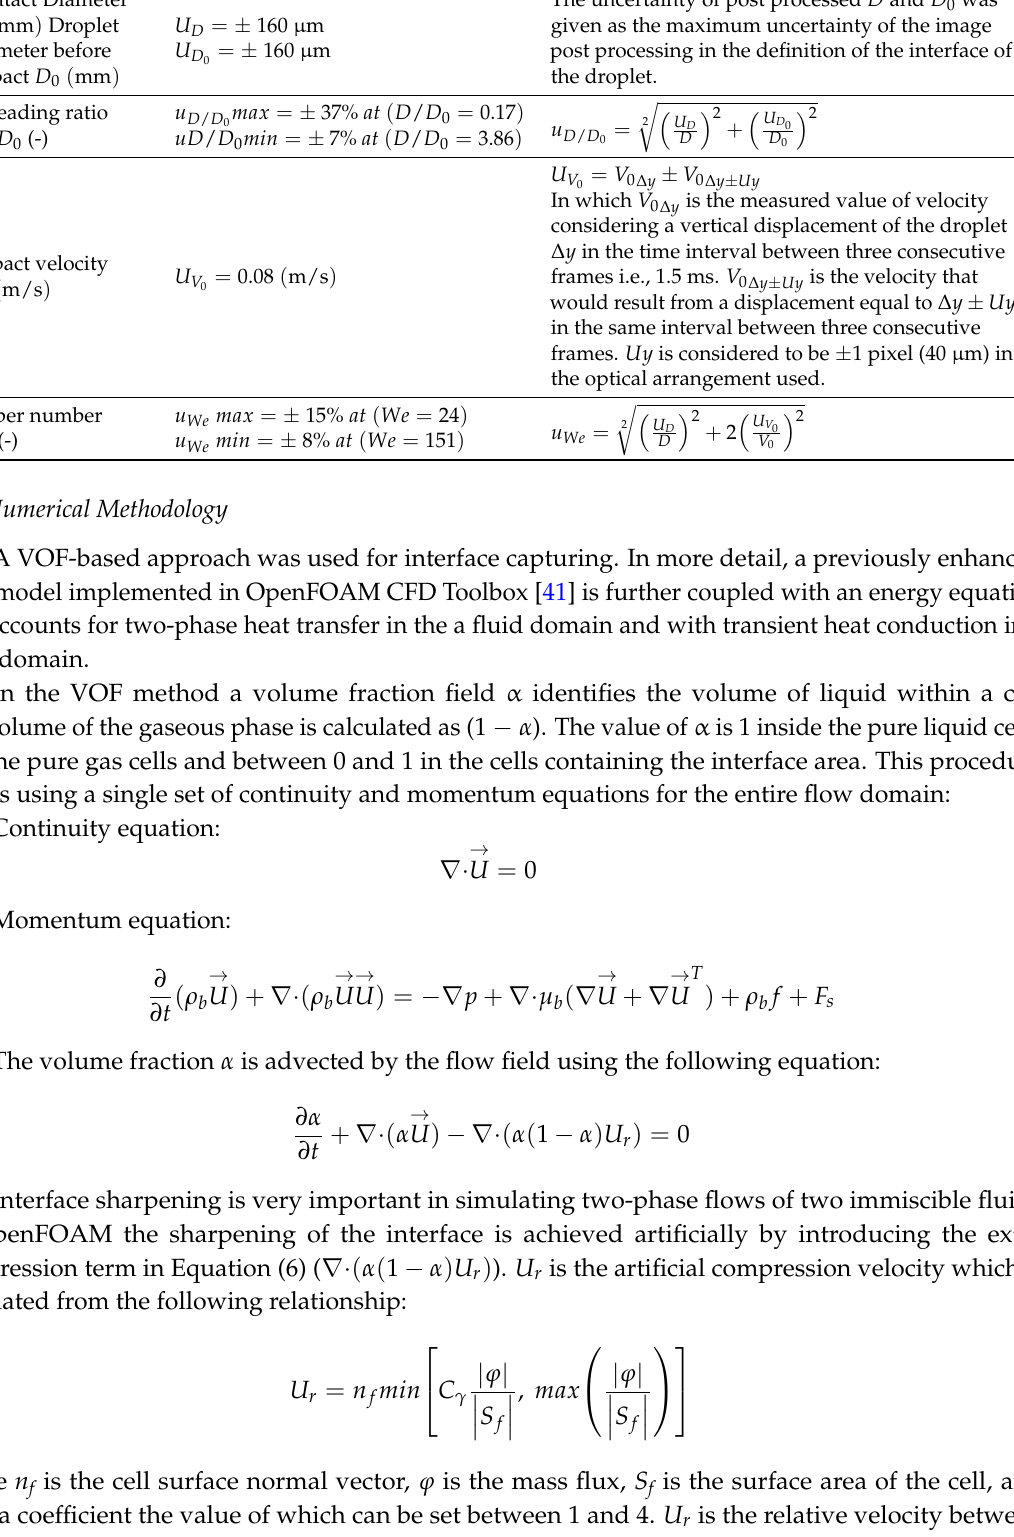
The uncertainty of post processed D and D 0 was given as the maximum uncertainty of the image post processing in the definition of the interface of the droplet.